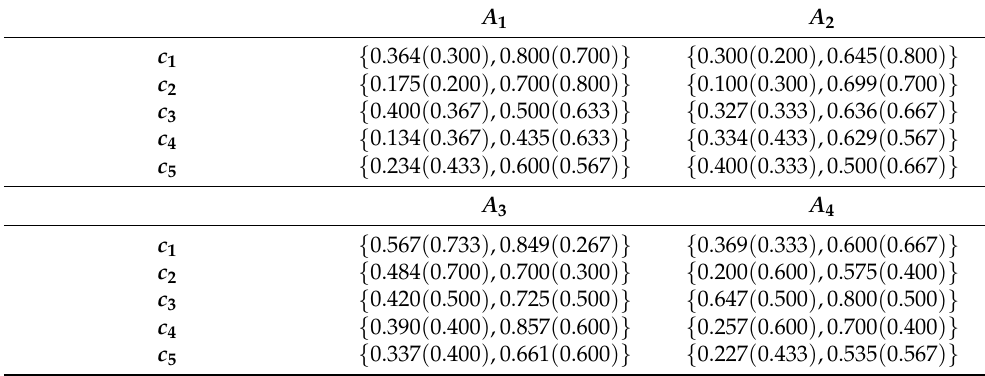
Table 7. Evaluation matrix H